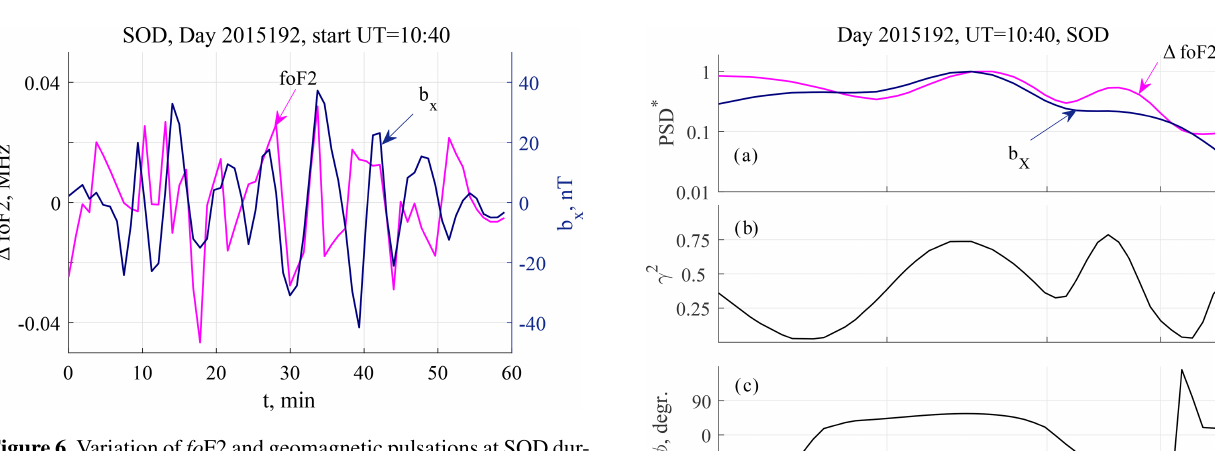
Figure 6. Variation of fo F2 and geomagnetic pulsations at SOD dur- ing event 2.